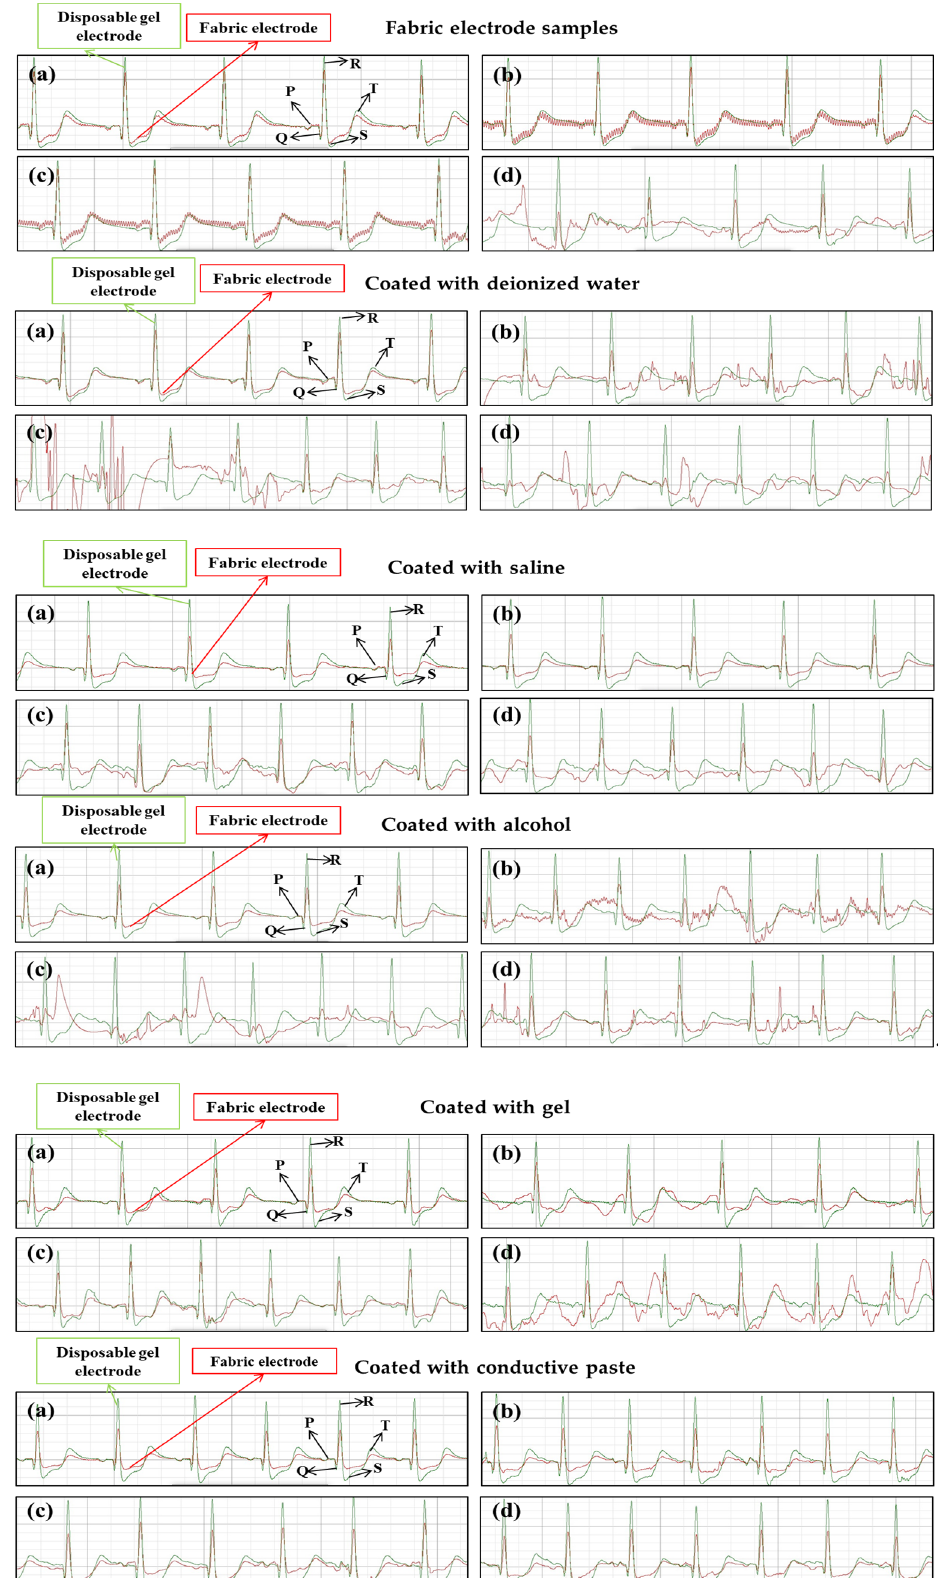
Figure 6. Dynamic and static ECGs collected at different states of the fabric electrode interface. ( a ) Static state. ( b ) Sitting down and standing up. ( c ) Walking in place. ( d ) Expanding the chest.